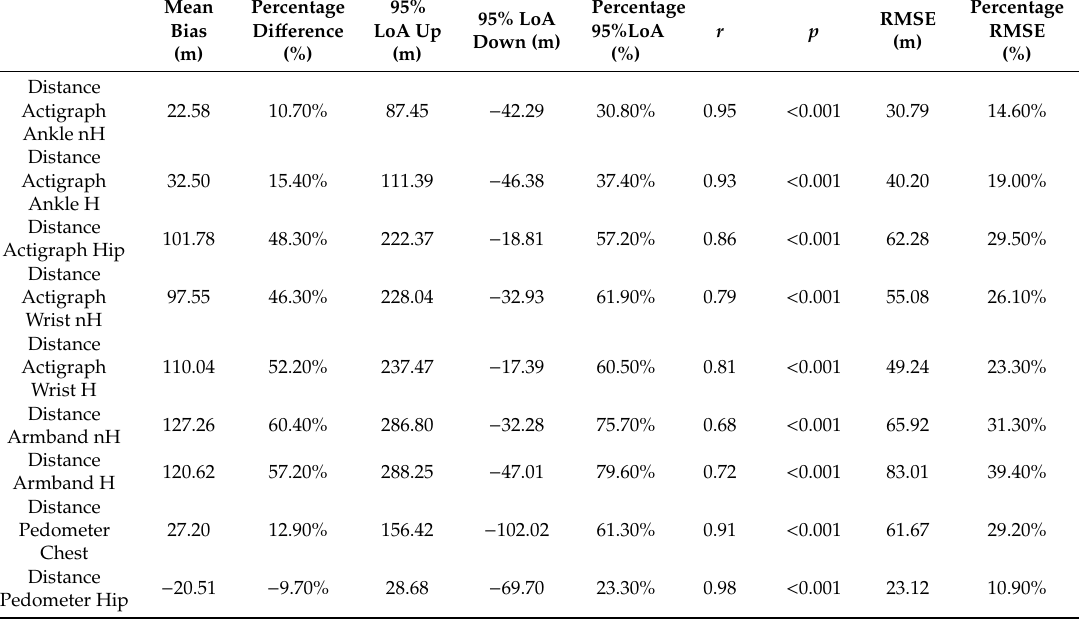
Table 3. Validity parameters of distance estimated by wearable devices versus distance measured by examiner. Unit in meters; nH: non hemiparetic side; H: hemiparetic side; percentage di ff erence: mean bias expressed in percentage of distance measured and estimated by device; 95% LoA: limits of agreement of Bland–Altman analysis; r = Pearson correlation coe ffi cient; p = statistical significance of Pearson correlation coe ffi cient; RMSE: root-mean-square error; percentage RMSE: RMSE expressed in percentage of distance measured by